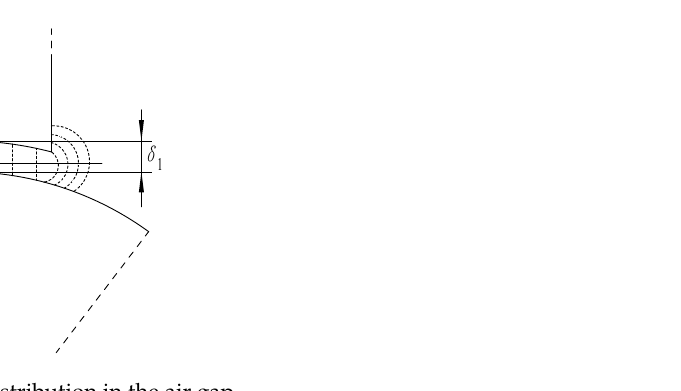
D 2 P Figure 4. Structure diagram of self-inductive displacement sensor. In the figure: D -rotor diameter; D 0 -inner diameter of stator; D 1 -inner diameter of stator yoke; D 2 -outer diameter of stator; A 0 -mag- netic pole area; P -width of pole shoe; N 1 -the number of coil turns; d 0 -diameter of coil wire. The stator and rotor cores of the designed sensor are made of WG35WW250 silicon steel sheets, and the stator core is made of 10 silicon steel sheets of the same structure and